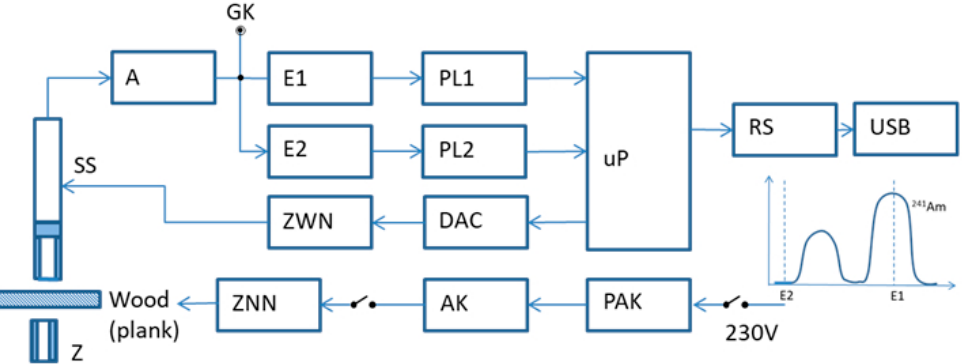
Figure 1. Diagram of the isotope X-ray density meter MGD-05, where Z—source of radiation (241Am),